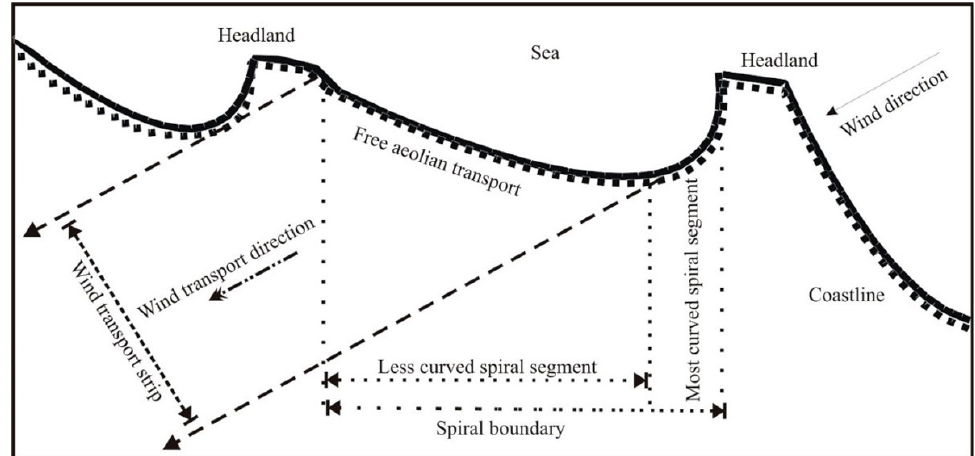
Figure 2. The conceptual model for coastal morphology shows the variation in the coastal segment and its relationship with aeolian transport and foredunes formation (modified from